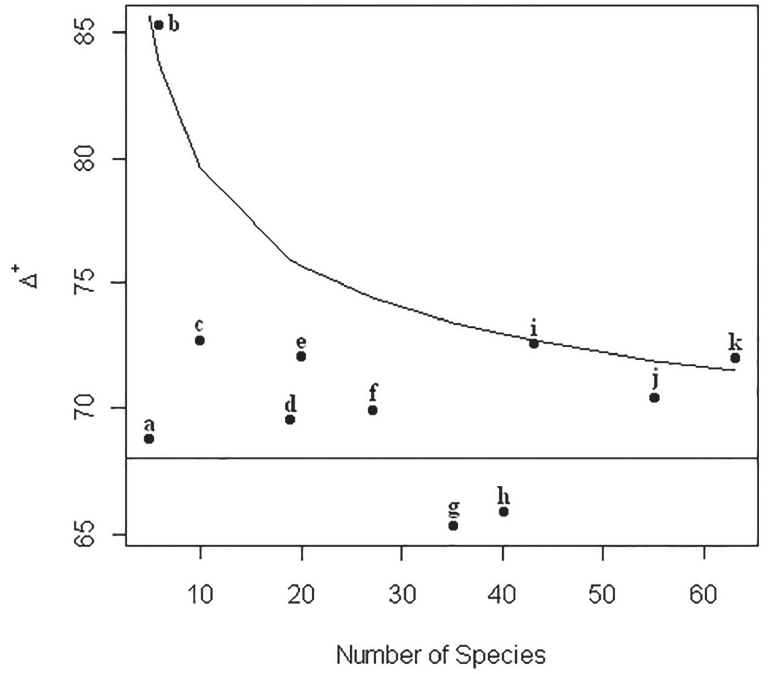
Figure 2 - Taxonomic distinctness of sandstone caves in Igatu and Lencóis. a-Cobras cave; b-Morro de Alvo cave; c-Criminoso cave; d-Veio de Aurélio cave; e-Torras System; f-Cantinho cave; g-Canal da Fumaça cave; h-Ressurgência do Morro de Alvo cave; i-Lava Pé cave; j-Rio dos Pombos cave; k-Parede Vermelha cave. Δ + means Taxonomic Distinctness. Funnel graph means 95% confidence limits.